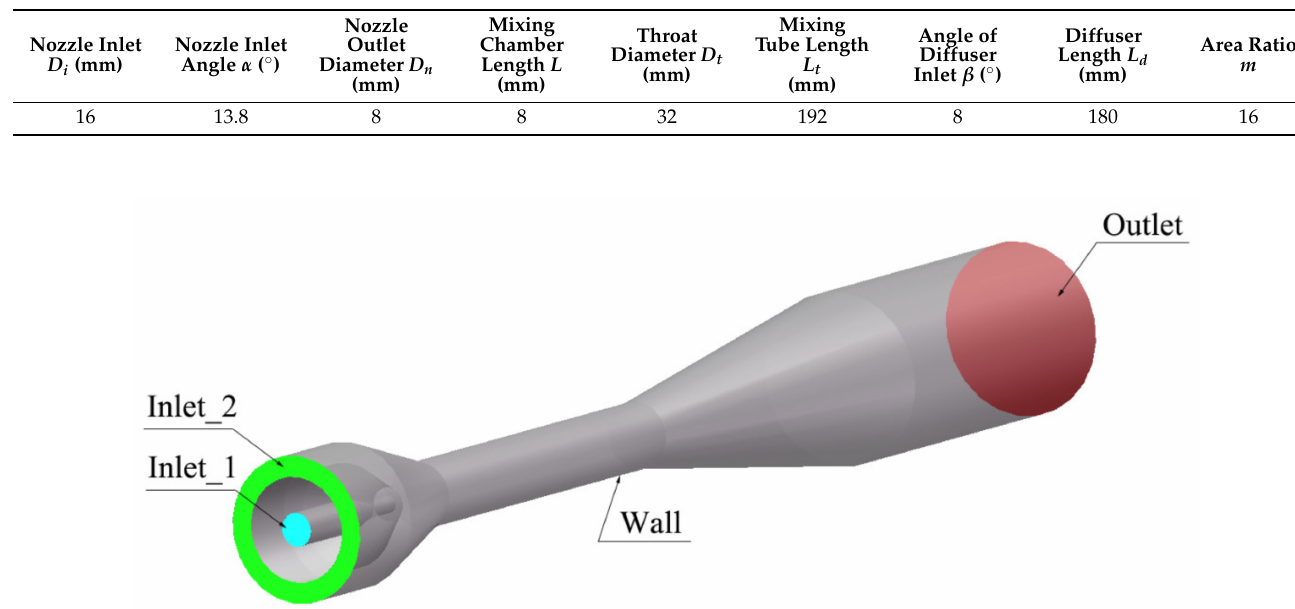
Figure 2. The 3D computational domain and boundary conditions of the jet